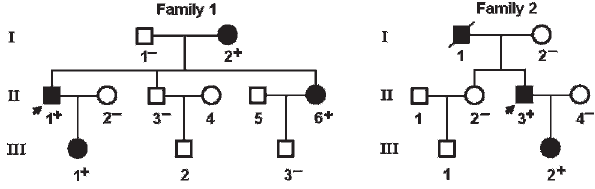
Figure 2 - The pedigrees of the families with atrial fibrillation. The families are designated as Family 1 and Family 2. Family members are identified by generation and number. Squares indicate male family members; circles, female members; a symbol with a slash, a deceased member; closed symbols, affected members; open symbols, unaffected members; arrows, probands; ‘‘ + ’’, carriers of the heterozygous mutations; and ‘‘ 2 ’’,